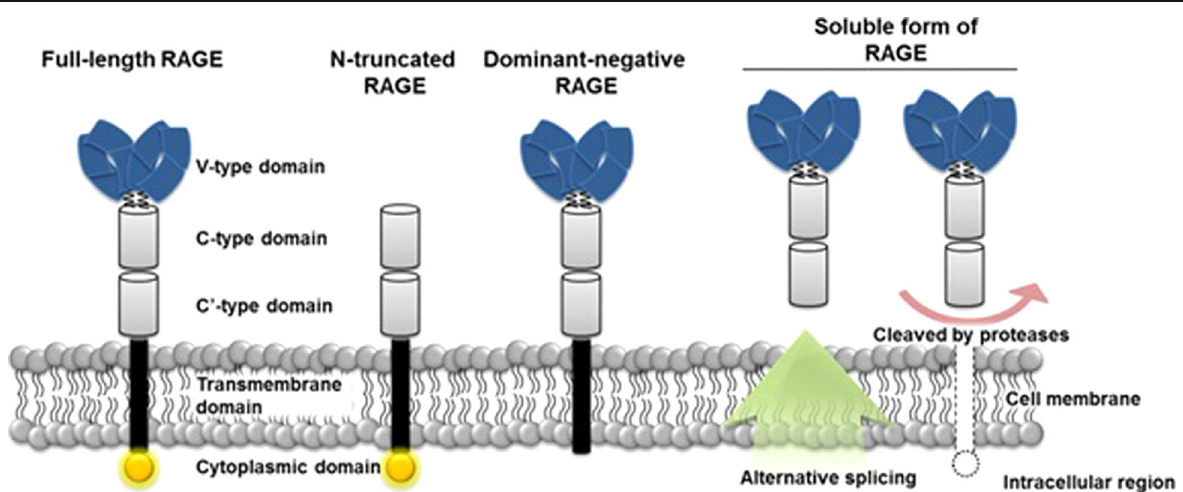
Fig. 1 Major RAGE isoforms. The full length receptor includes one cytoplasmic domain involved in signal transduction, and three extracellular domains comprised of two c-type domains and one v-type domain. The N-truncated isoform lacks AGE binding properties and is not activated by ligand binding. Dominant negative RAGE serves as a cell-bound decoy receptor. It lacks a cytosolic domain and is not involved in signal transduction. Soluble RAGE consists of the complete extracellular domain, produced either via alternative splicing and directly secreted from the cell, or as a by-product of cleavage of full length RAGE by extracellular proteases. Copied with permission from Lee EJ, Park JH, Genomics